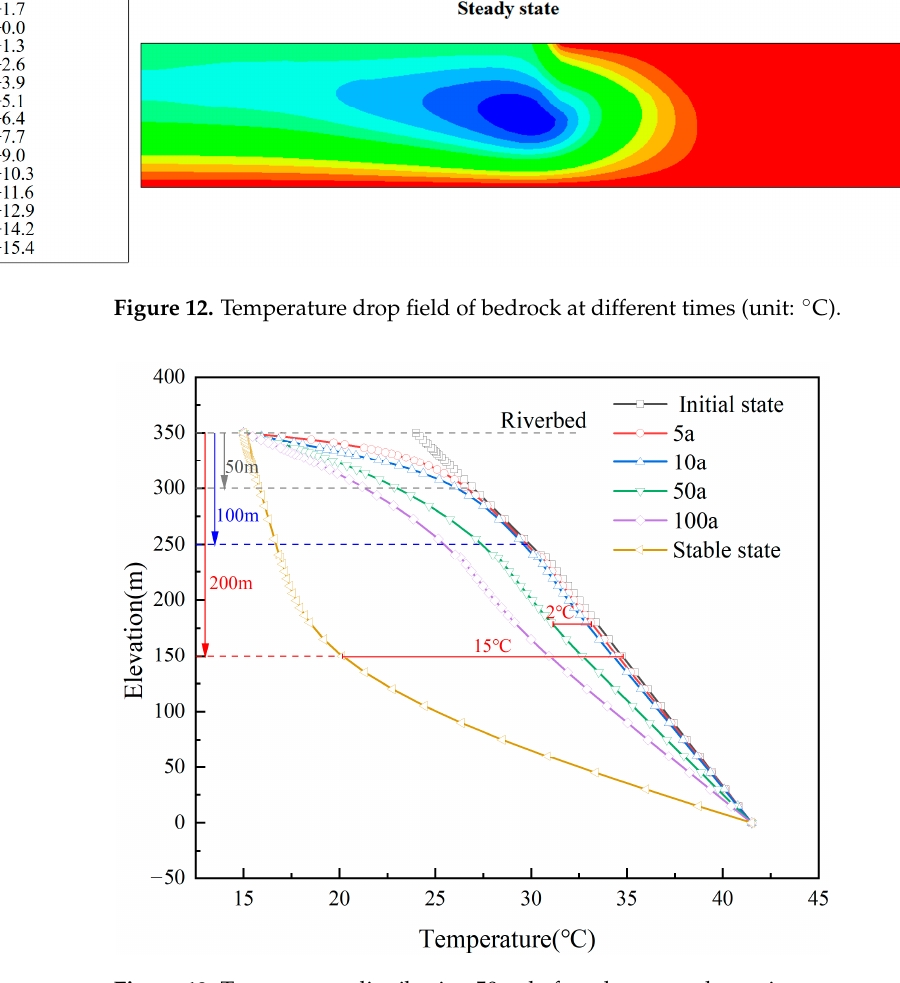
Figure 13. Temperature distribution 50 m before the grouted curtain.